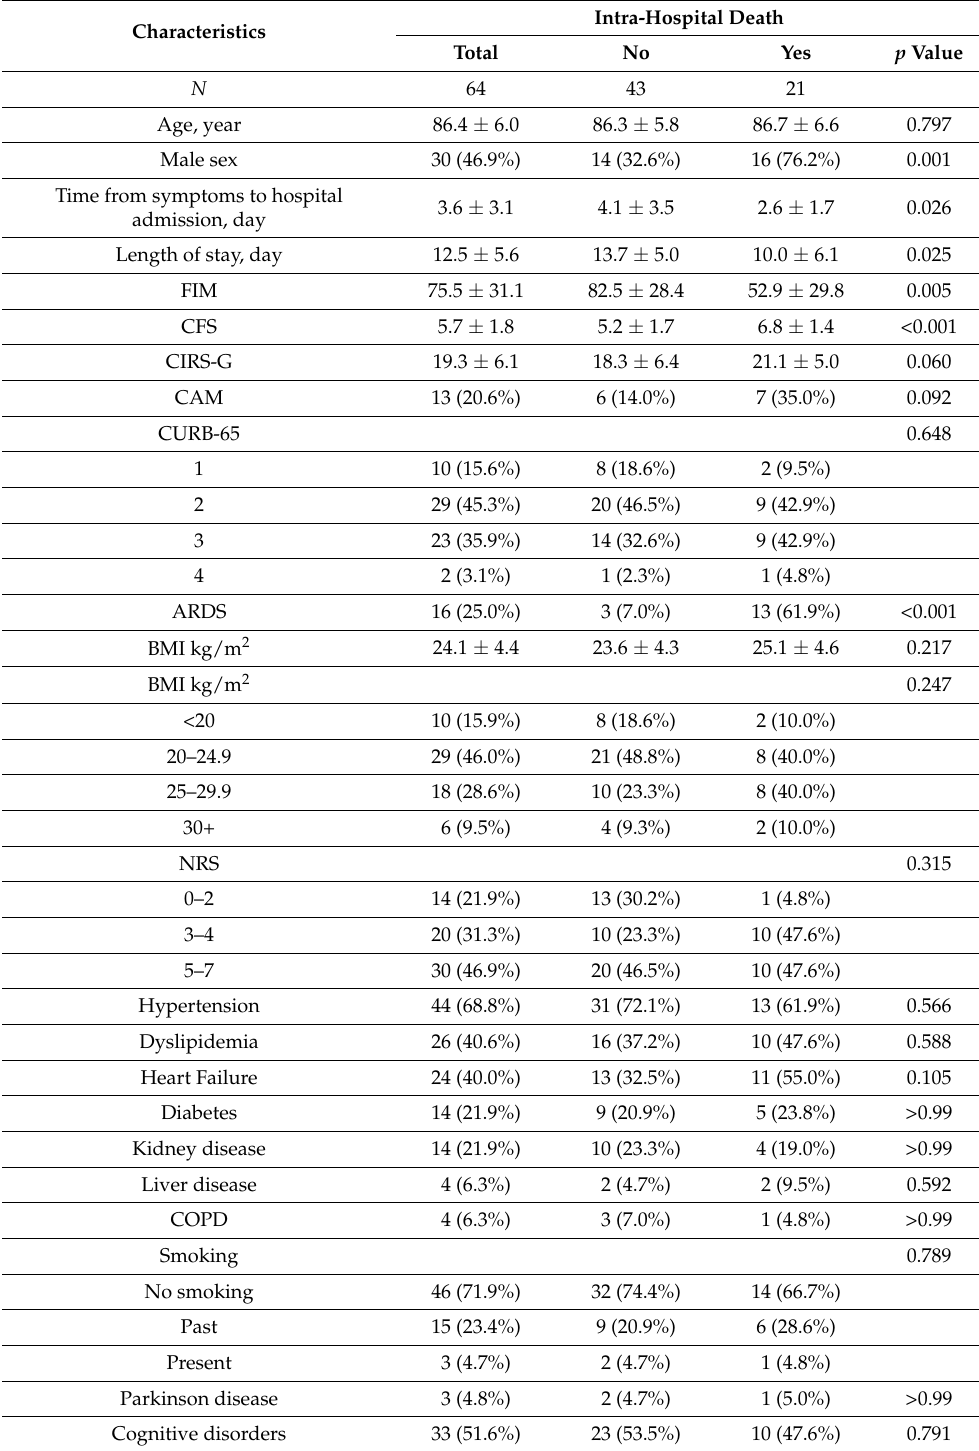
Table 1. Characteristics of the study